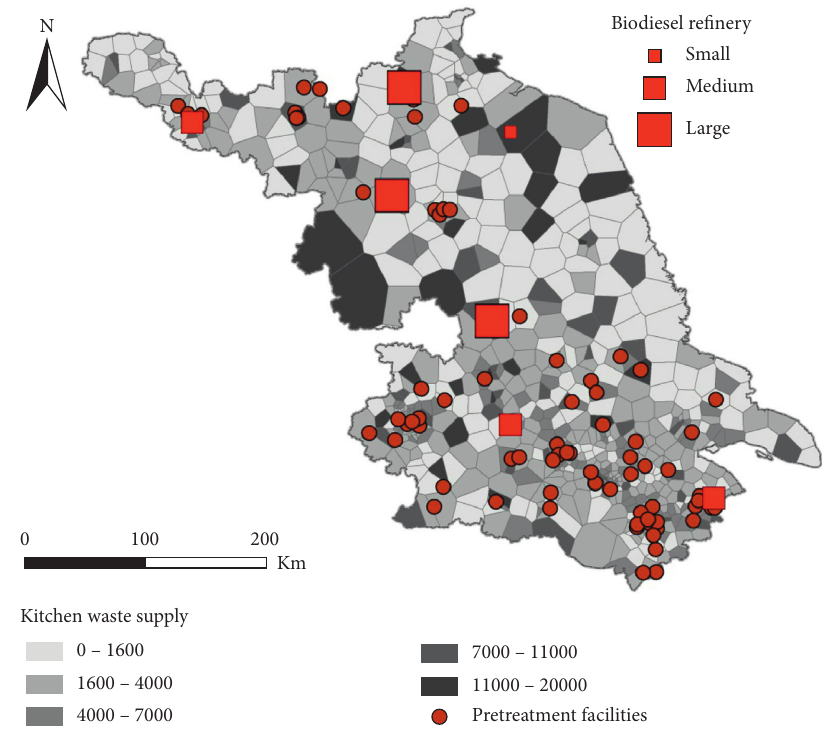
Figure 11: Results of biodiesel refineries and pretreatment facilities